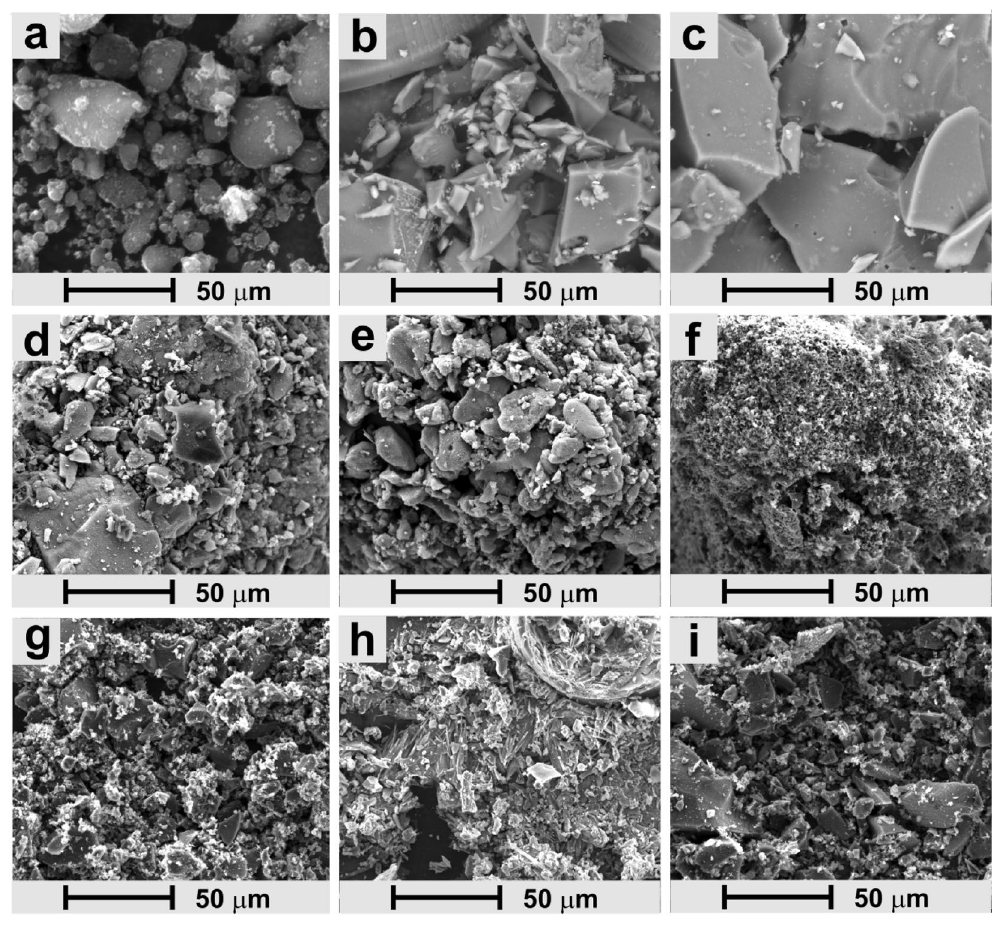
Figure 6. SEM images of ( a ) CNO, ( b ) RF-C , (c) RF-CNO-C , ( d ) RFM-C , ( e ) RFM-CNO-C , ( f ) BX-C , ( g ) BX-CNO-C , ( h ) CLX-C , and ( i ) CLX-CNO-C